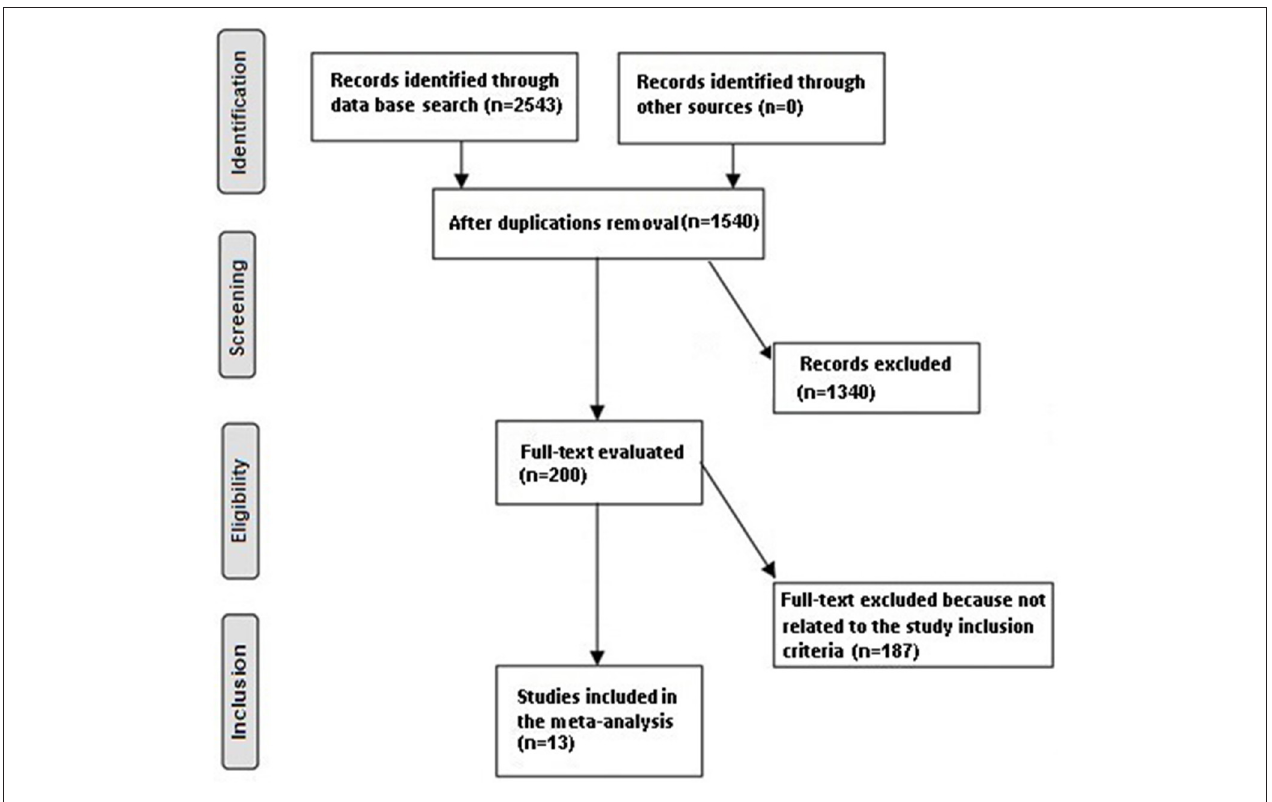
FIGURE 1 | Schematic diagram of the study procedure.